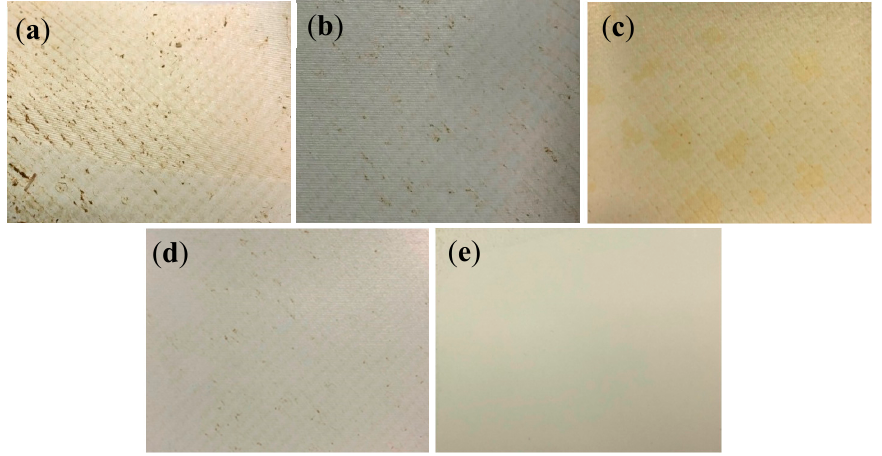
Figure 4. Optical images of fouled and cleaned membranes of ( a ) P1, ( b ) P2, ( c ) P1-clean, ( d ) P2-clean, and ( e ) the virgin membrane.